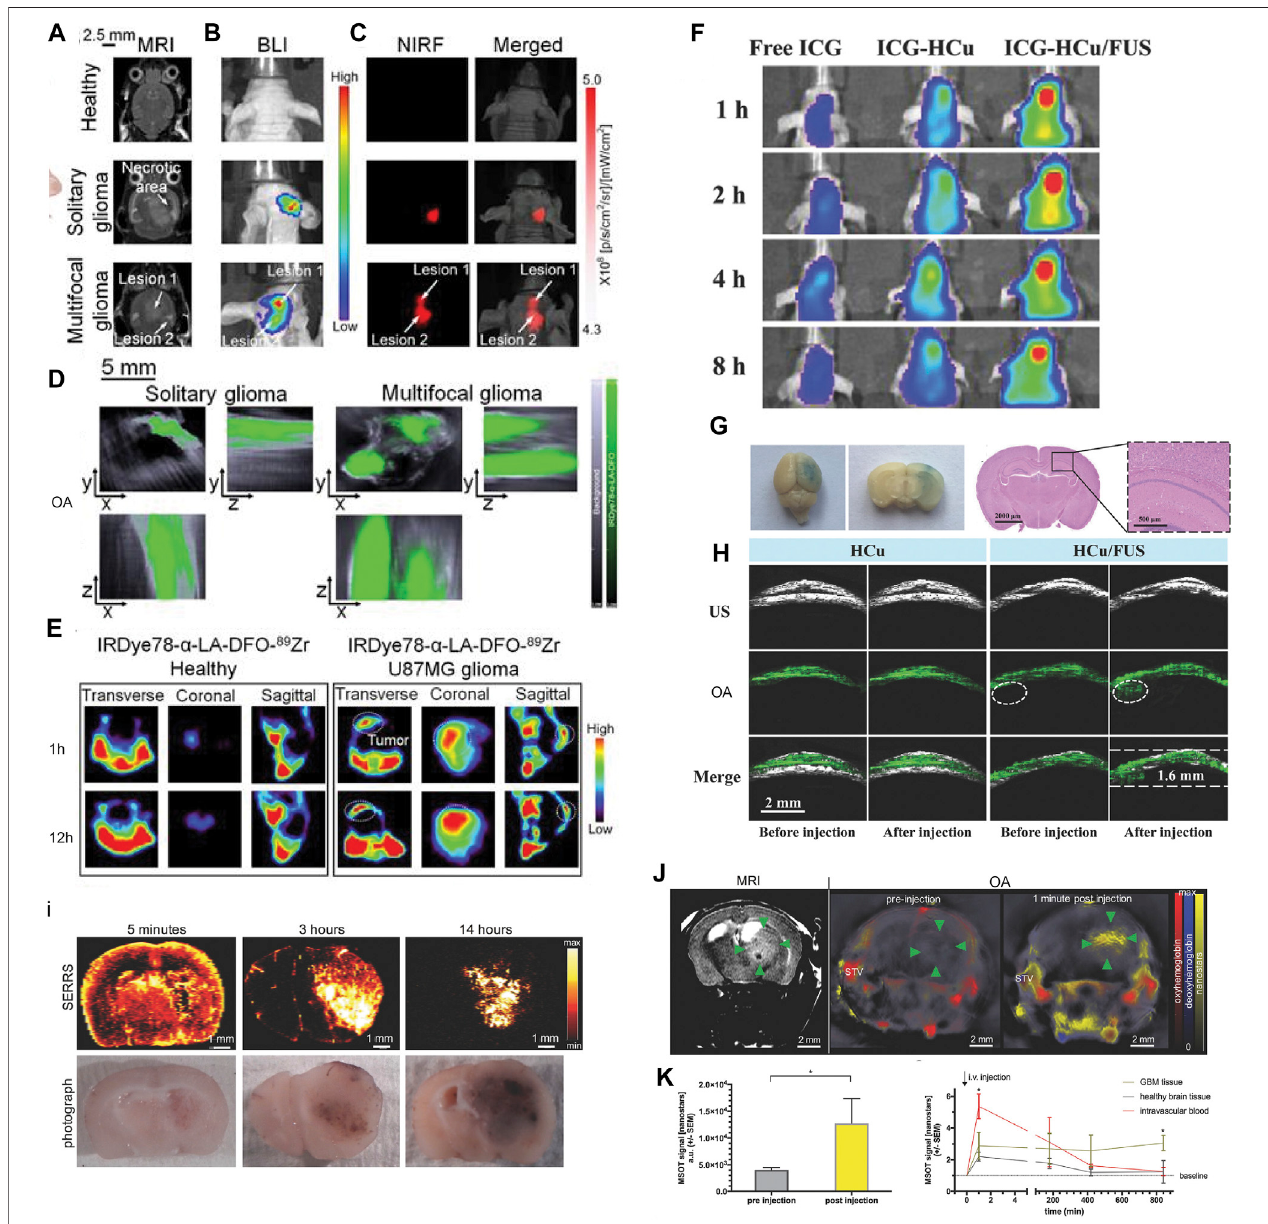
FIGURE 2 | (A – C) Imaging of U-87MG orthotopic brain tumors using IRDye78- α -LA-DFO. (A) Coronal T 2 -weighted MRI, (B) bioluminescence imaging, (C) NIR fl uorescence imaging, and (D) OA imaging of healthy mice and mice with the solitary and bilobed orthotopic gliomas after i.v. injection of IRDye78- α -LA-DFO. (E) PET imagingofU-87MGgliomaafter i.v. injectionofIRDye78- α -LA-DFO[ 89 Zr]comparedtoahealthycontrol.Reproducedfromref.Yangetal.(2021)withpermissionfromthe Ivyspring International Publisher. (F – H) Focused ultrasound (FUS) – augmented delivery of biodegradable inorganic hybrid hollow mesoporous organosilica nanoparticles-ss-Cu 2 − x Se (HCu) nanosystems for brain tumor detection; (F) In vivo fl uorescence images of U87 glioma-bearing mice after i.v . injection with free indocyanine green (ICG), ICG-HCu, and ICG-HCu/FUS; (G) Evans Blue and hematoxylin and eosin staining of the mouse brain after FUS-induced blood – brain barrier opening; (H) ultrasound(US),OA,and overlayimages oforthotopicbraintumorsacquiredbeforeandafter i.v. injection ofHCuwithoutor withFUS-inducedblood – brain barrieropening.Reproduced fromref.WuM.etal.(2018) withpermissionfromtheWILEY-VCHVerlagGmbH&Co.KGaA,Weinheim. (I – L) MultimodalOA/MRI/Raman imaging using SERRS-MSOT nanostars in glioblastoma-bearing mice. (I) The pharmacokinetic pro fi le of the nanostars over the course of 14 h after i.v. injection con fi rmed by ex vivo SERRS Raman imaging; (J,K) T 2 -weighted MRI and OA imaging showing a signi fi cantly increased OA signal unmixed for the nanostars (yellow) in the tumorous area (green arrowheads) and blood circulation (STV, super fi cial temporal artery and vein, * p < 0.05); (L) the peak signal in the blood stream gradually declined over time. No remnant signal deriving from the nanostars was detectable by OA in the blood or the healthy brain tissue area on the contralateral hemisphere. Reproduced from ref. Neuschmelting et al. (2018) with permission from the WILEY-VCH Verlag GmbH & Co. KGaA, Weinheim.